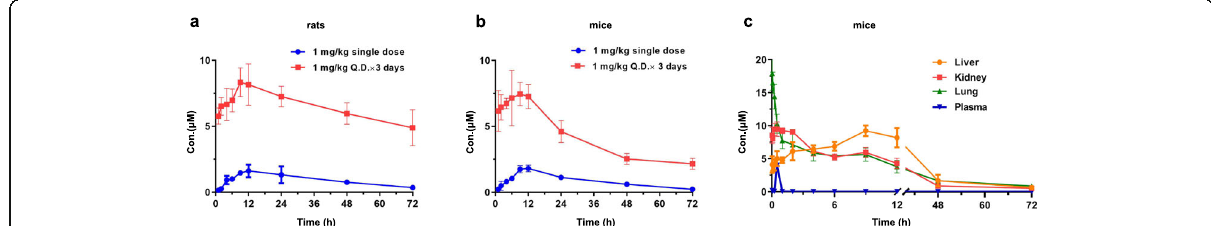
Fig. 3 Mean lung concentration – time curves of Emetine in rats and mice after oral administration at a single dose of 1 mg/kg and multi-doses of Q.D. 1 mg/kg in three consecutive days ( n = 3). a Distribution of Emetine in the lung of rats post 72 h with 1 mg/kg single oral dose and 1 mg/kg Q.D. for 3 days. b Distribution of Emetine in the lung of mice post 72 h with 1 mg/kg single oral dose and 1 mg/kg Q.D. for 3 days. c Distribution of Emetine in different tissues of mice after intravenous administration of 1 mg/kg in